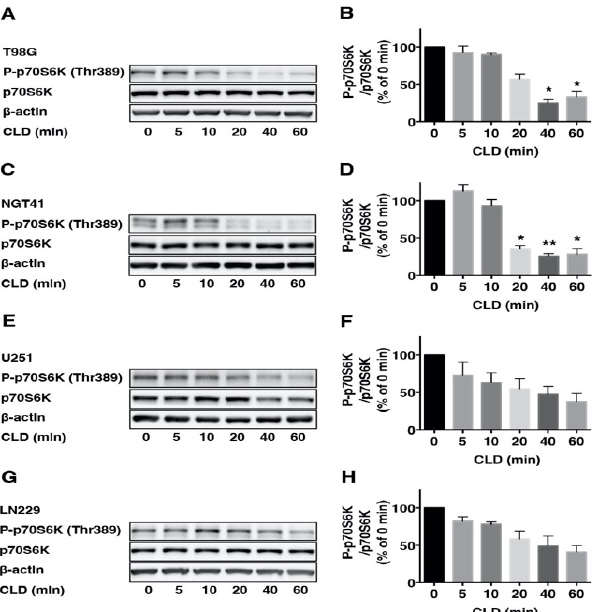
Figure 3. Time course effect of clindamycin on the phosphorylation of p70S6K in glioblastoma cell lines. Time course analysis of clindamycin (CLD) on p70S6K phosphorylation was determined in glioblastoma cell lines ( A , C , E , G ). Cells were assigned to the indicated times and cultured with CLD (440 µ M) and subjected to Western blotting. The levels of phosphorylation and total p70S6K were quantified after standardizing the ratio of phospho/total p70S6K ( B , D , F , H ). β -actin was used as the internal control level in all cases. Data are shown as the mean ± SE, similar results were obtained